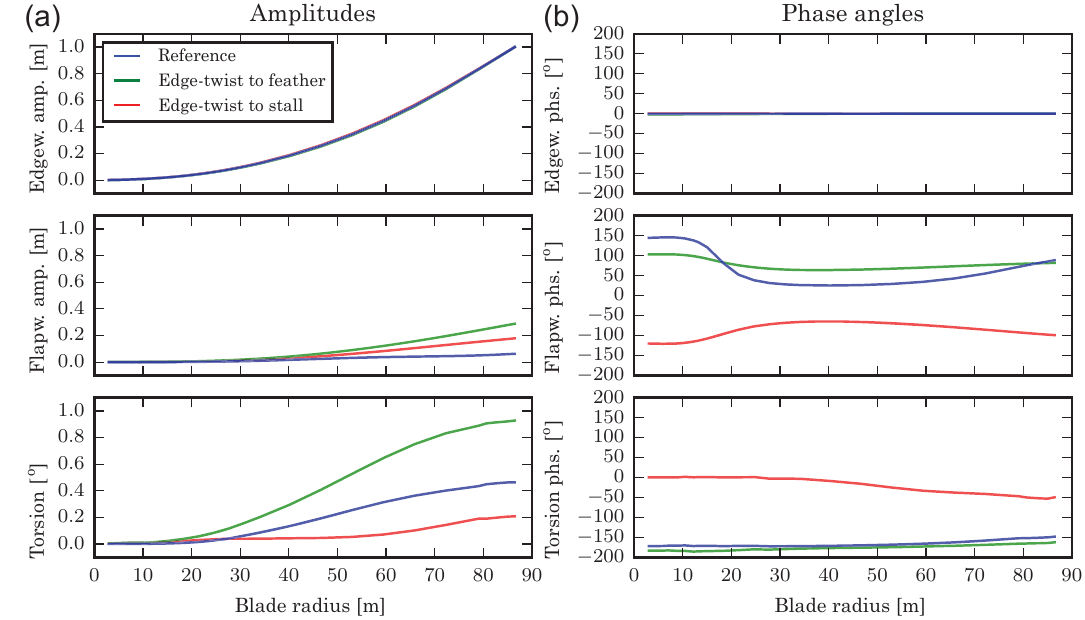
Figure 16. Amplitudes (a) and phase angles (b) of the first aeroelastic edgewise mode as indicated in Fig. 15 at approx. 140ms − 1 tip speed for the reference (blue), and edge–twist to feather (green) and stall (red) coupled DTU 10MW RWT blade. Coupling coefficients are γ x = ± 0 . 1 constant along the blade. Amplitudes are normalized to 1.0m tip deflection in the edgewise direction, and phase angles are relative to the edgewise tip